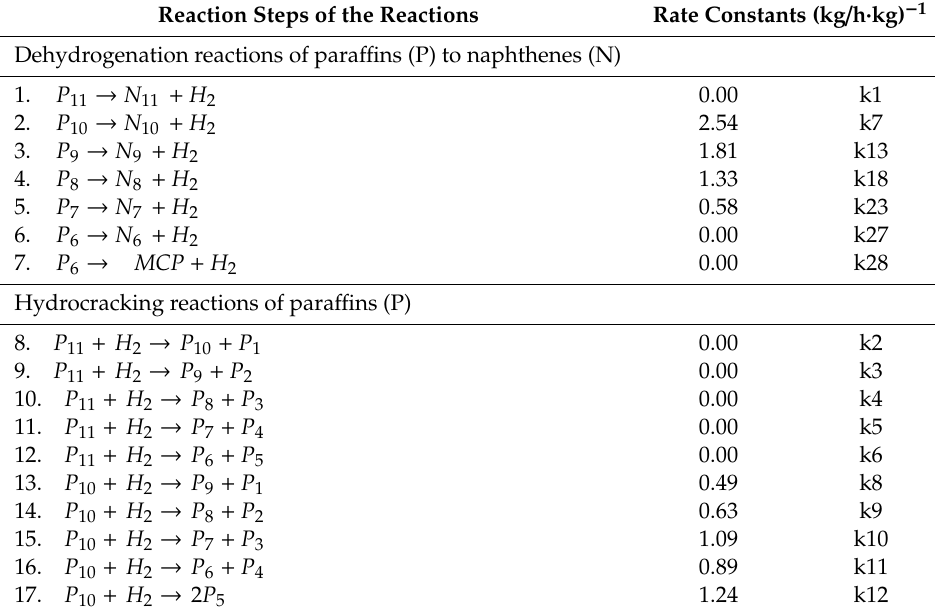
Table 2. Table of reaction steps and rate constants of the Model (adapted from [10]). Reaction Steps of the